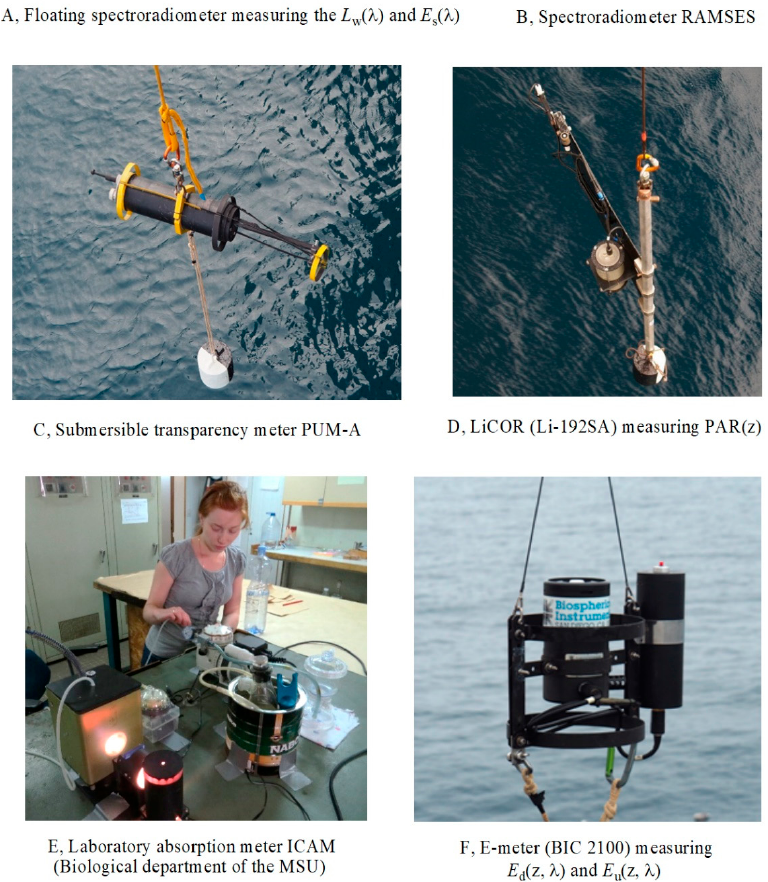
Figure 1. The basic instruments for field measurements. Photos captured by A.V. Grigoriev ( A – D , F ) and D. I. Glukhovets ( E ), both from the Shirshov Institute of Oceanology (SIO RAS) used here with permission.